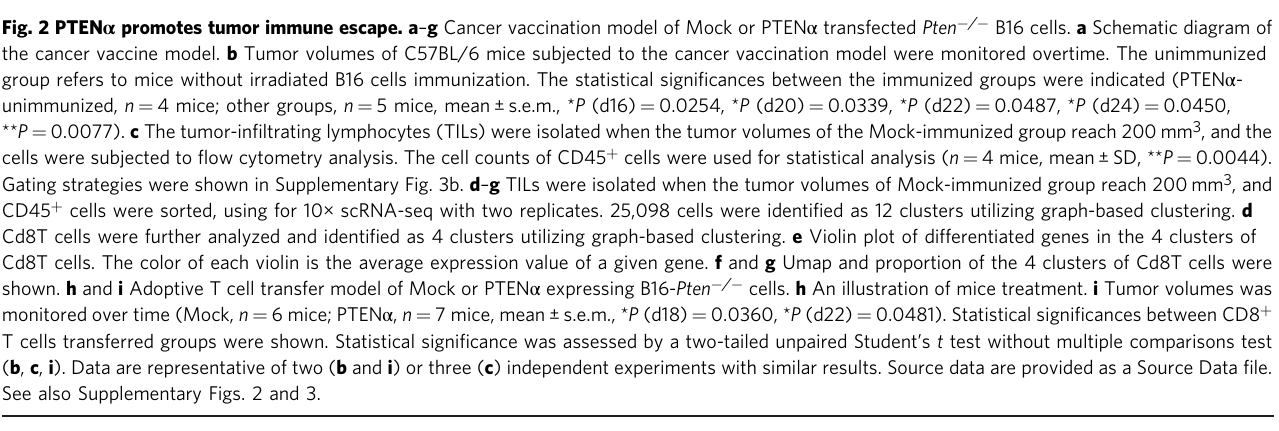
Fig. 2 PTEN α promotes tumor immune escape. a – g Cancer vaccination model of Mock or PTEN α transfected Pten − / − B16 cells. a Schematic diagram of the cancer vaccine model. b Tumor volumes of C57BL/6 mice subjected to the cancer vaccination model were monitored overtime. The unimmunized group refers to mice without irradiated B16 cells immunization. The statistical signi fi cances between the immunized groups were indicated (PTEN α - unimmunized, n = 4 mice; other groups, n = 5 mice, mean ± s.e.m., * P (d16) = 0.0254, * P (d20) = 0.0339, * P (d22) = 0.0487, * P (d24) = 0.0450, ** P = 0.0077). c The tumor-in fi ltrating lymphocytes (TILs) were isolated when the tumor volumes of the Mock-immunized group reach 200 mm 3 , and the cells were subjected to fl ow cytometry analysis. The cell counts of CD45 + cells were used for statistical analysis ( n = 4 mice, mean ± SD, ** P = 0.0044). Gating strategies were shown in Supplementary Fig. 3b. d – g TILs were isolated when the tumor volumes of Mock-immunized group reach 200 mm 3 , and CD45 + cells were sorted, using for 10× scRNA-seq with two replicates. 25,098 cells were identi fi ed as 12 clusters utilizing graph-based clustering. d Cd8T cells were further analyzed and identi fi ed as 4 clusters utilizing graph-based clustering. e Violin plot of differentiated genes in the 4 clusters of Cd8T cells. The color of each violin is the average expression value of a given gene. f and g Umap and proportion of the 4 clusters of Cd8T cells were shown. h and i Adoptive T cell transfer model of Mock or PTEN α expressing B16- Pten − / − cells. h An illustration of mice treatment. i Tumor volumes was monitored over time (Mock, n = 6 mice; PTEN α , n = 7 mice, mean ± s.e.m., * P (d18) = 0.0360, * P (d22) = 0.0481). Statistical signi fi cances between CD8 + T cells transferred groups were shown. Statistical signi fi cance was assessed by a two-tailed unpaired Student ’ s t test without multiple comparisons test ( b , c , i ). Data are representative of two ( b and i ) or three ( c ) independent experiments with similar results. Source data are provided as a Source Data fi le. See also Supplementary Figs. 2 and